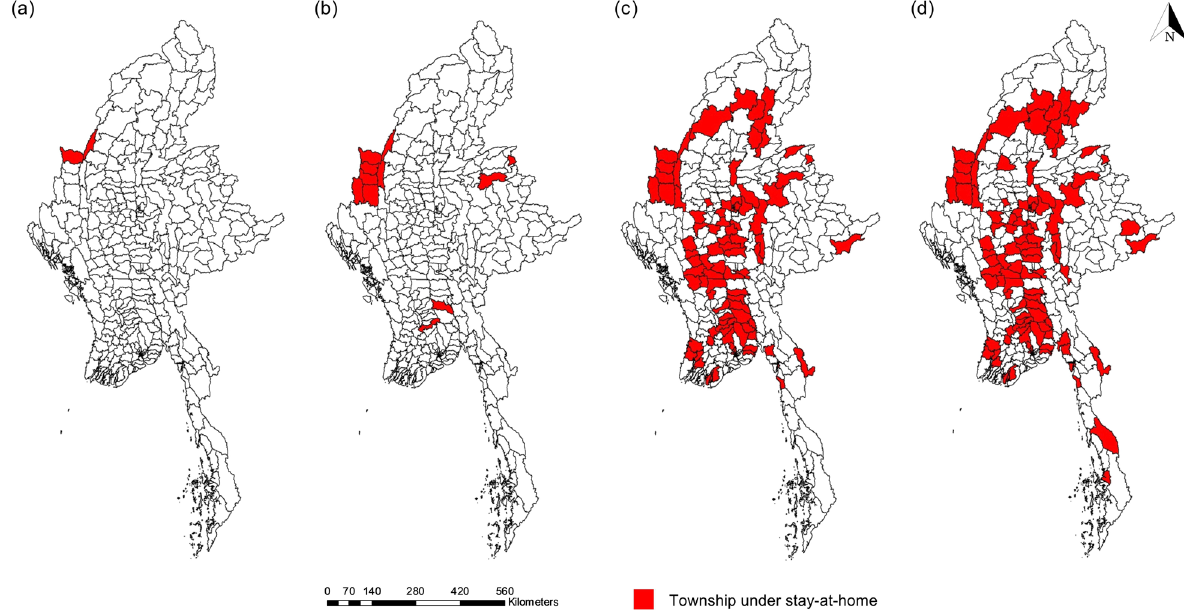
Fig. 2 Townships under stay-at-home in the third wave of COVID-19 epidemic in Myanmar from 29th May to 25th August 2021 ( a ) two townships under stay-at-home in May 2021 ( b ) 11 townships under stay-at-home from May to June 2021, c 108 townships under stay-at-home from May to July 2021, d 119 townships under stay-at-home from May to August